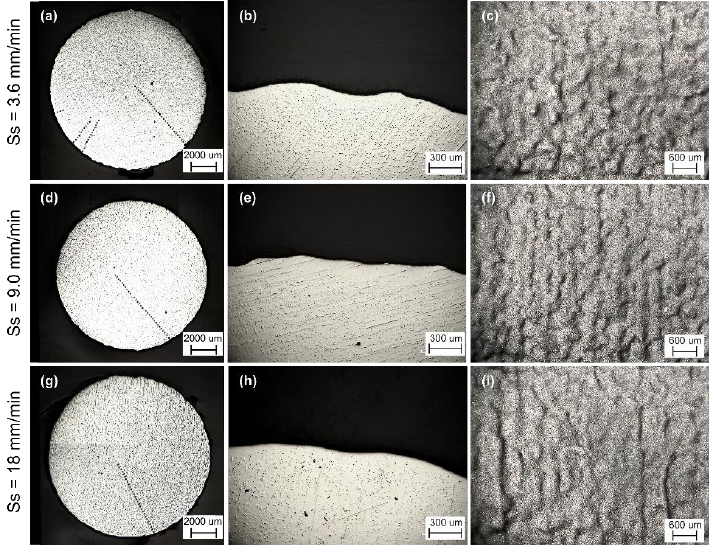
Figure 7. ( a , d , g ) Cross-sections, ( b , e , h ) their magnifications, and ( c , f , i ) surface morphologies after laser polishing at different Ss and Fd = 7.5 mm. Table 6. Circumferential overlap percentage (COP) at different scan speed and focal distance.